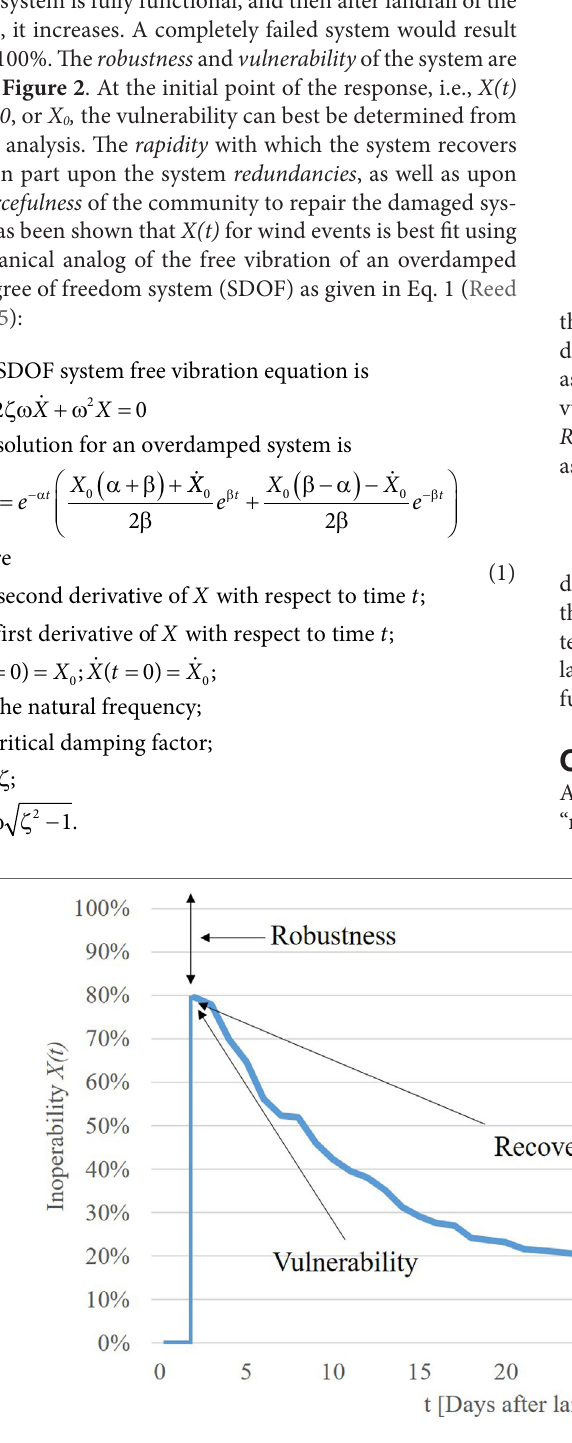
FigUre 2 | Inoperability X(t) function over time.